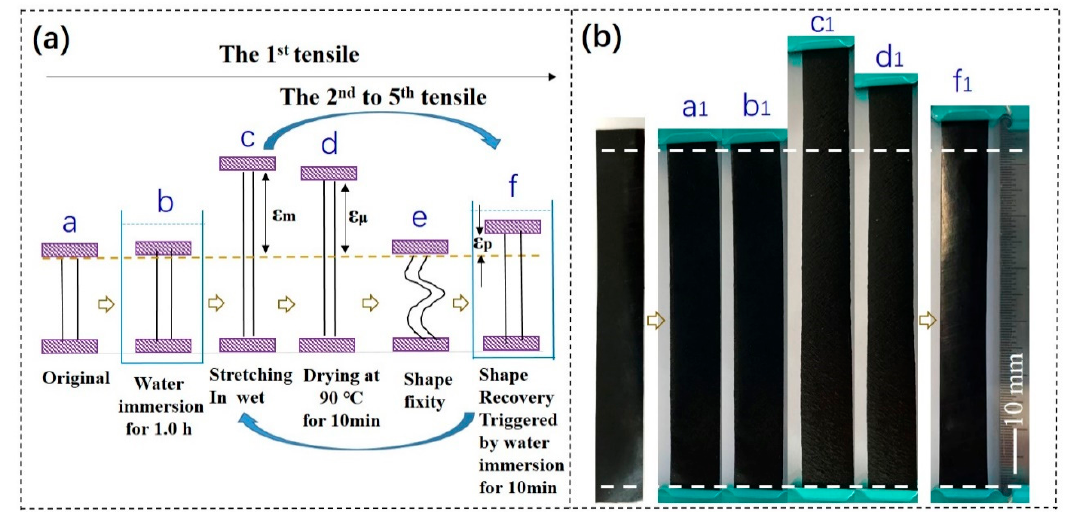
Figure 1. The cyclic tensile test to demonstrate the program of water-stimulus SME.